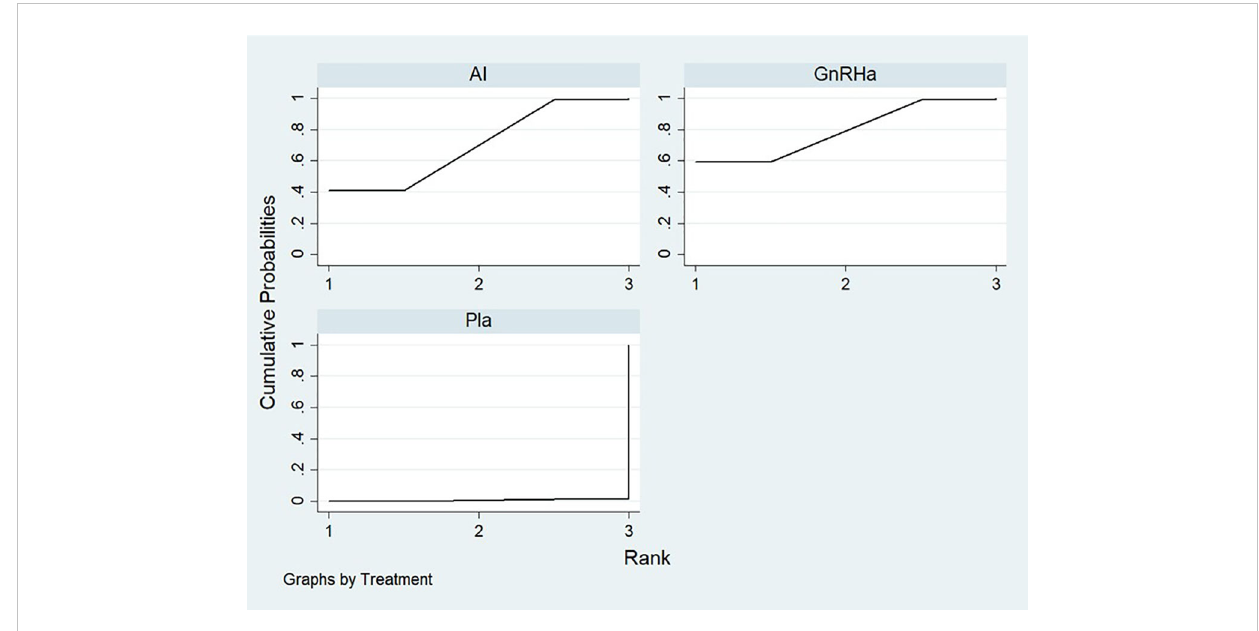
FIGURE 3 The SUCRA of placebo, AI, and GnRHa